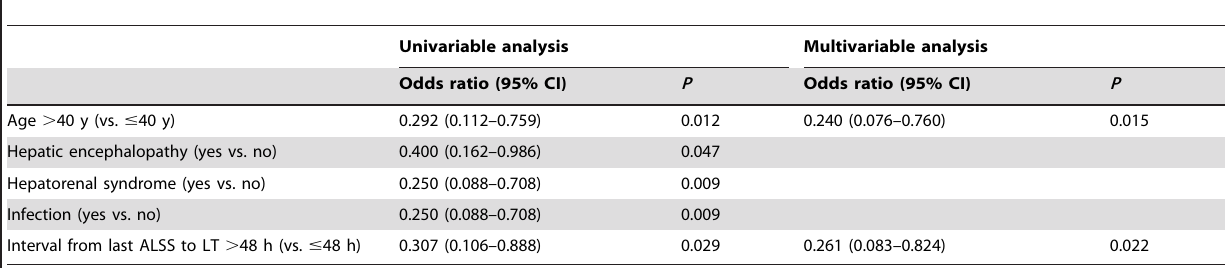
Table 3. Logistic regression for influence factors of downgrading